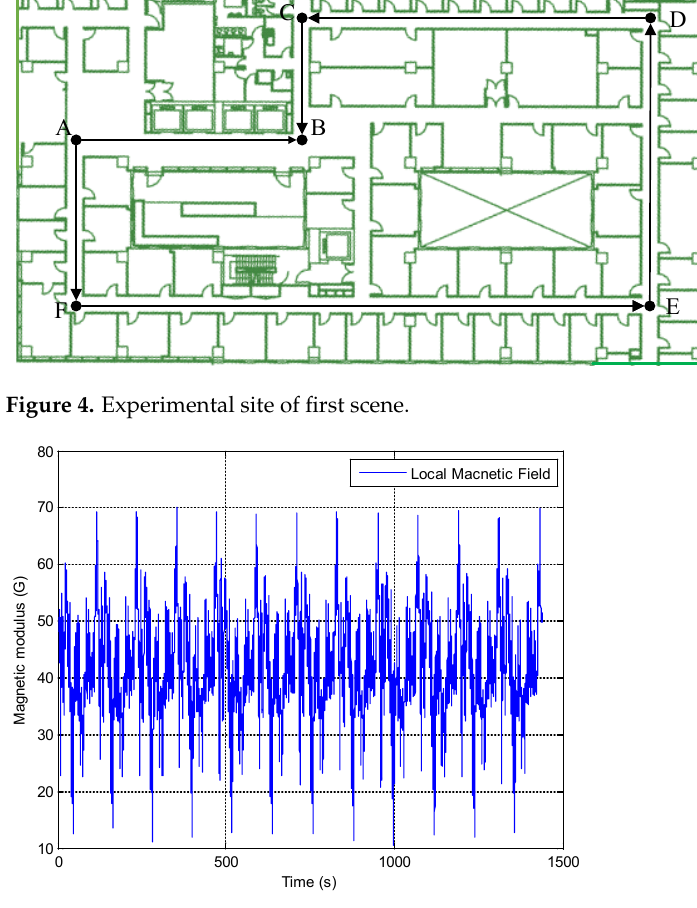
Figure 5. Description of indoor magnetic field.